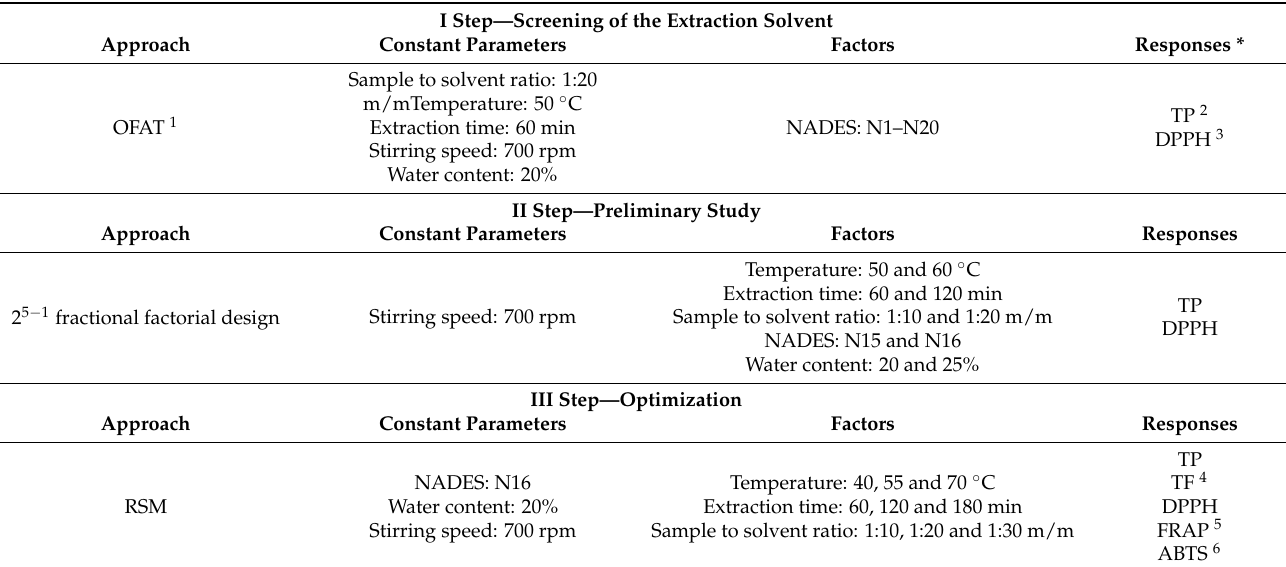
Table 7. Experimental plan for the isolation of polyphenolic antioxidants from wild thyme. I Step—Screening of the Extraction Solvent Approach Constant Parameters Factors Responses *